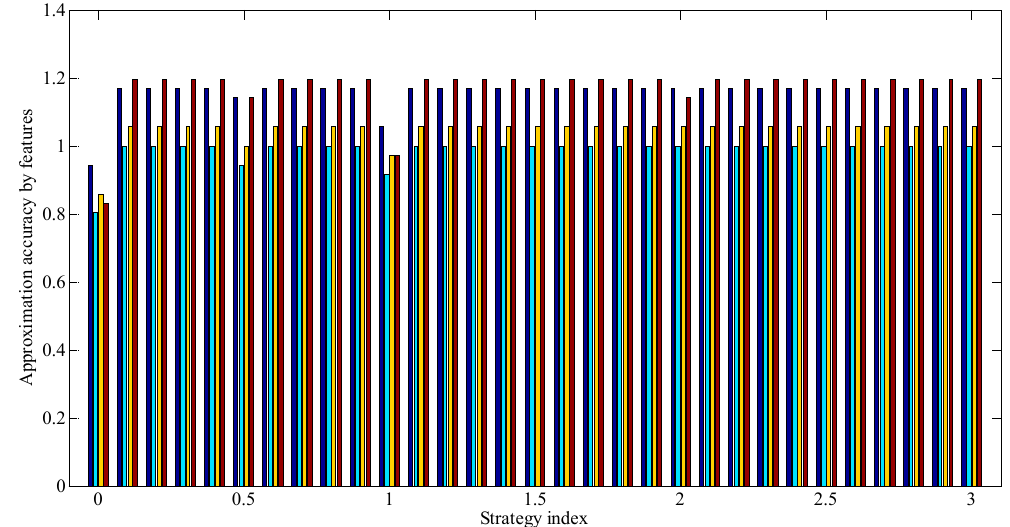
Figure 9. Diagram for the values of the approximation indicators by the assessment features of the individual classifications of CPs for different assessment strategies.